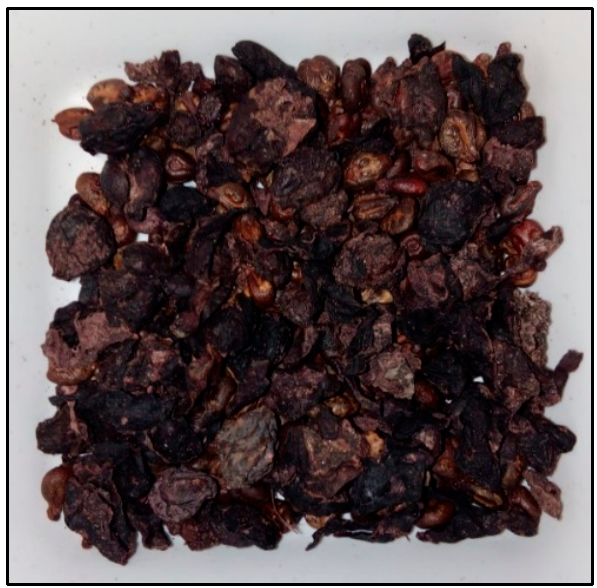
Figure 1. Camera picture of Grape Pomace Waste (seeds, skin, and stems).